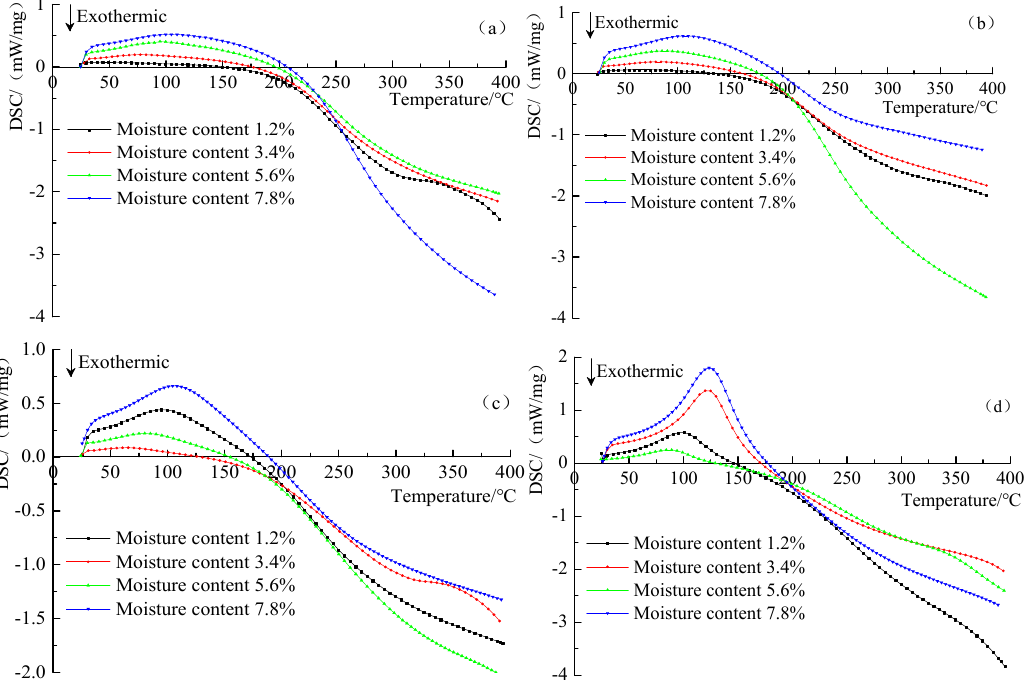
Figure 8. The DSC curves for anthracite ( a ), fat coal ( b ), long flame coal ( c ) and lignite ( d ) at four different low moisture contents.